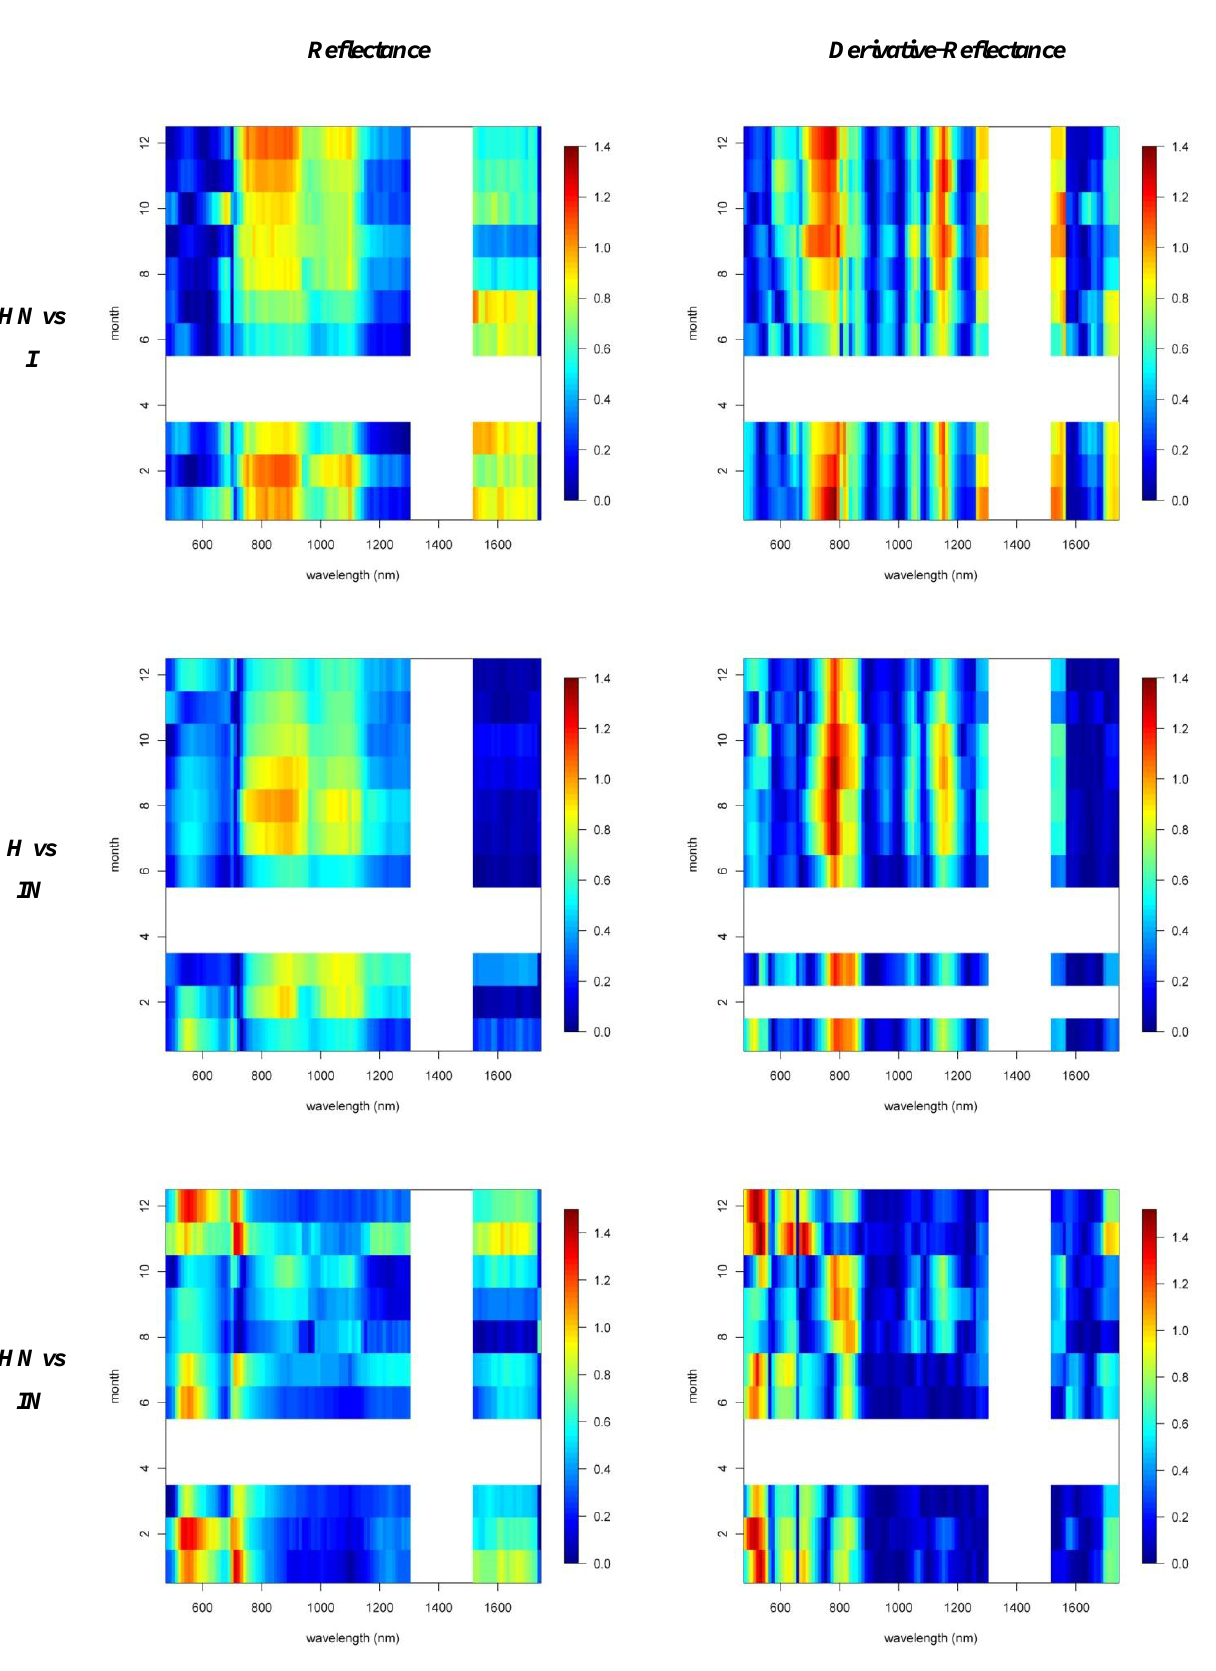
Figure 2. Cont. Reflectance